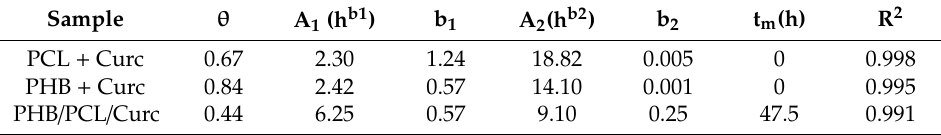
Table 3. Kinetic parameters evaluated from the fitting process of release data using Equation